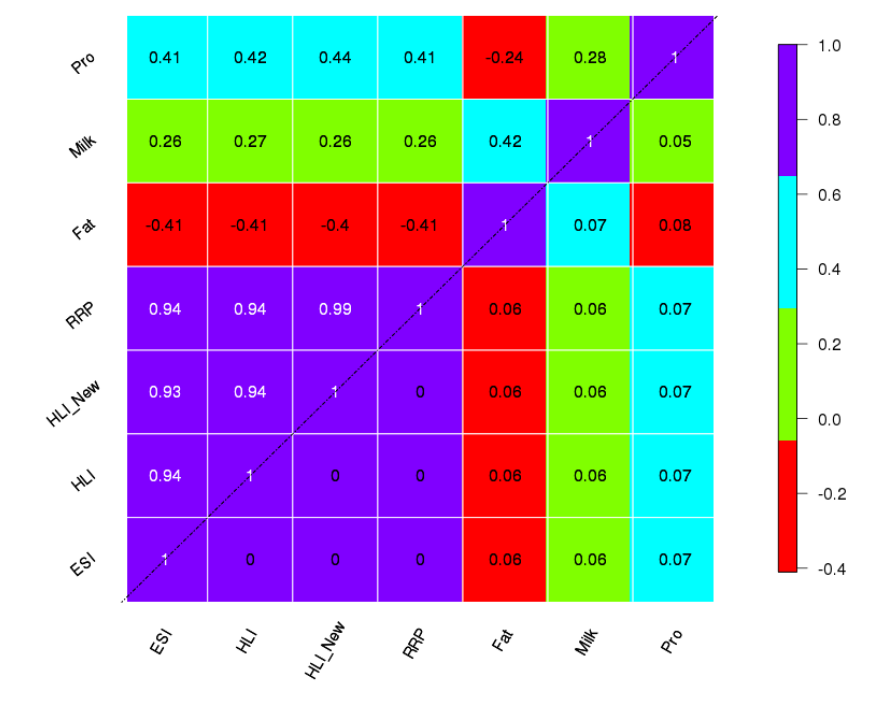
Figure 5. Correlation with bootstrapping between milk compounds and climatic indices in the spring (values under the diagonal are the estimated confidence intervals from the inter-quartile range).